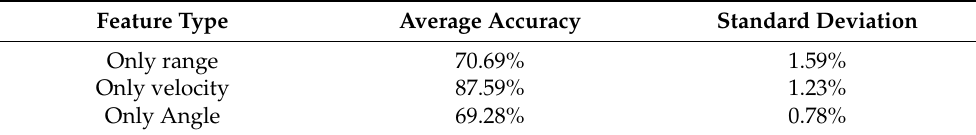
Figure 12. Accuracies based on single feature. Table 2. Comparison of accuracy based on a single